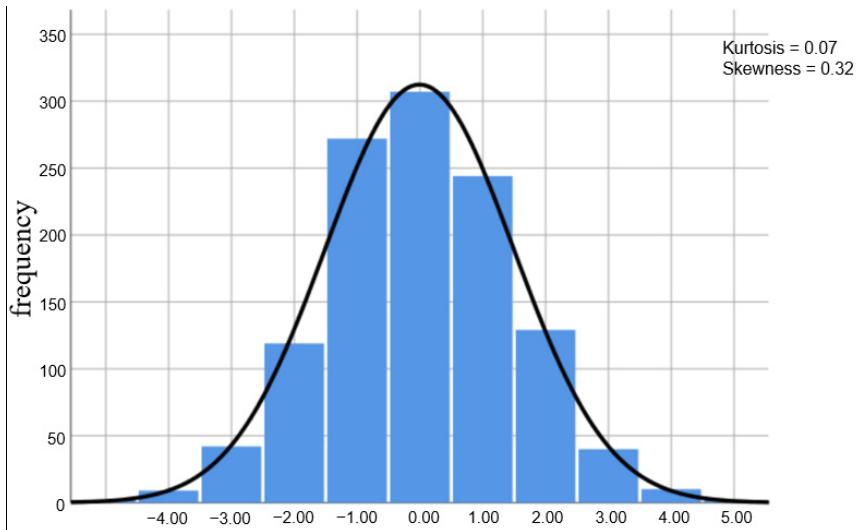
Figure 4. Expert opinion distribution.